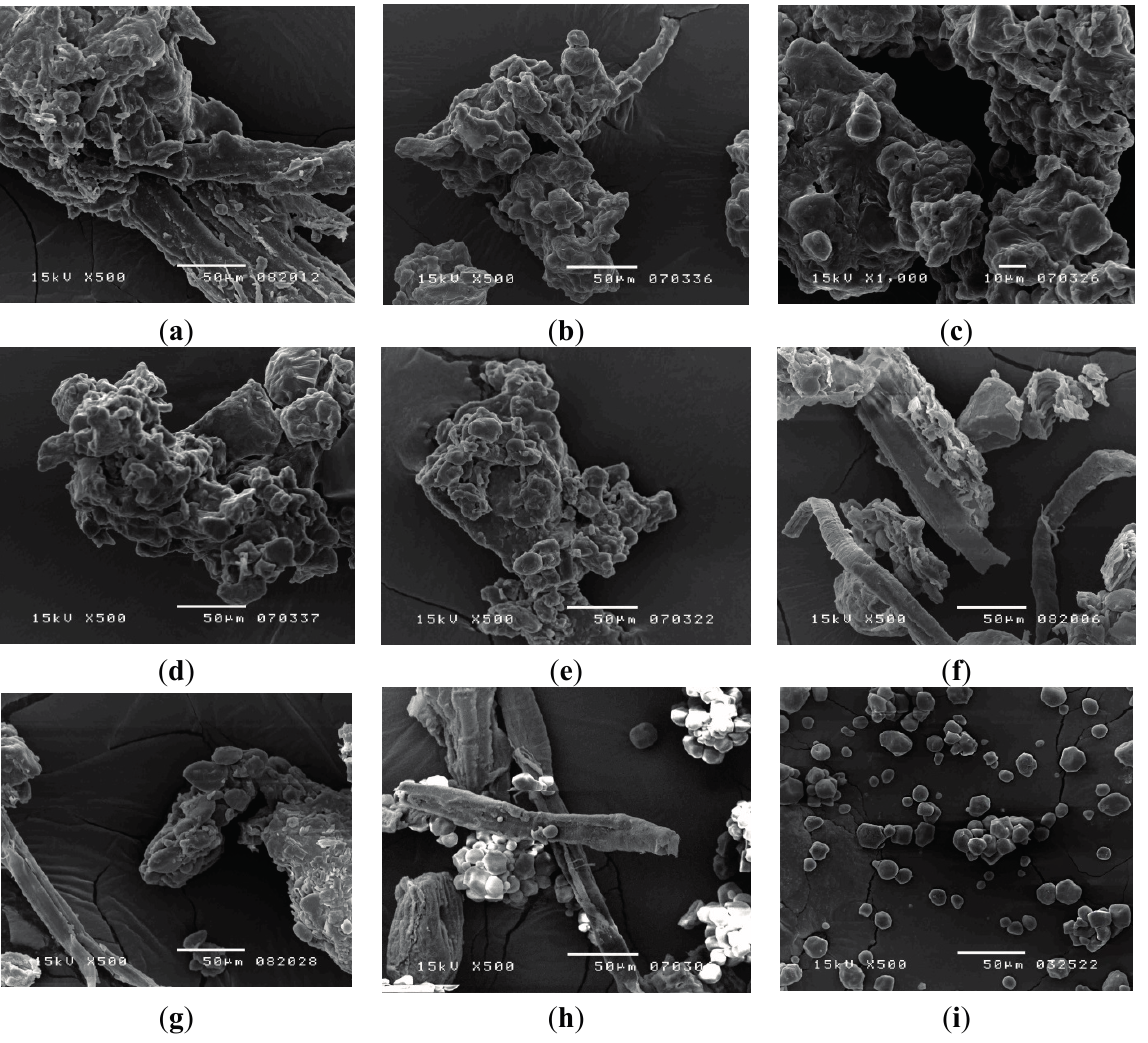
Figure 2. Scanning electron microscope images: ( a ) brand A; ( b ) brand B; ( c ) brand C; ( d ) brand D; ( e ) brand E; ( f ) herbal powder; ( g ) herbal powder:brand A = 1:1; ( h ) corn starch:herbal powder = 1:1 and ( i ) corn